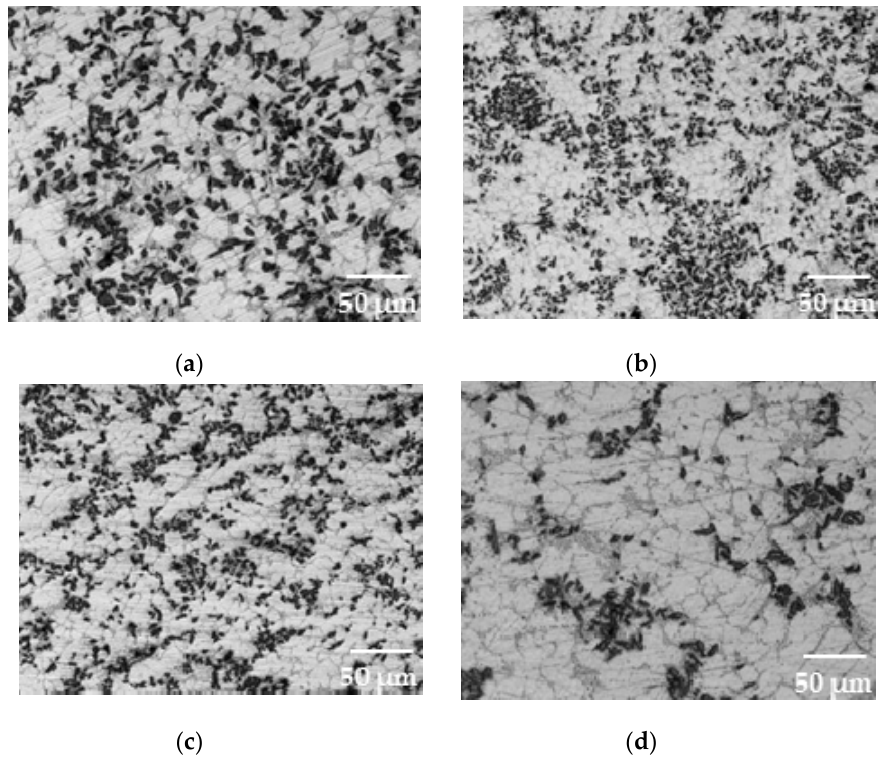
Figure 13. Cross - sectional microstructures of rheo - die-cast A356 / SiC ( 15%SiC - 15µm ) at Speed = 4 m / s and Pressure = 11 MPa in ( a ) position no . 1; ( b ) position no . 2; ( c ) position no . 3; and ( d ) position no . 4 .